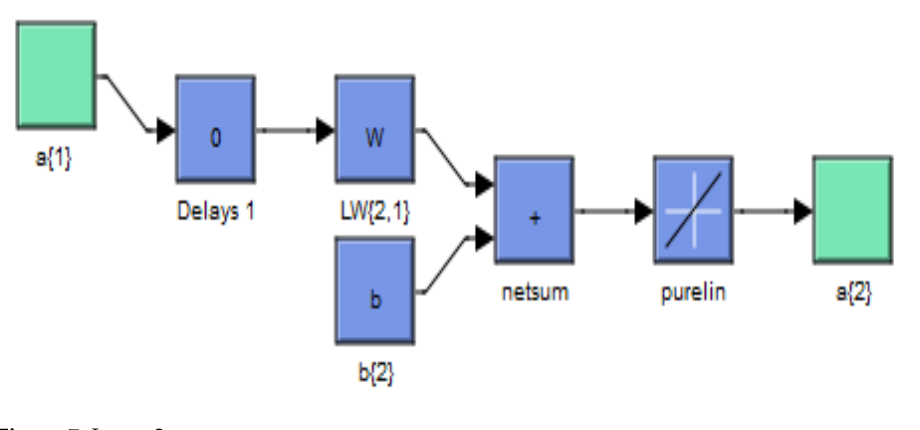
Figure 7. Layer 2.